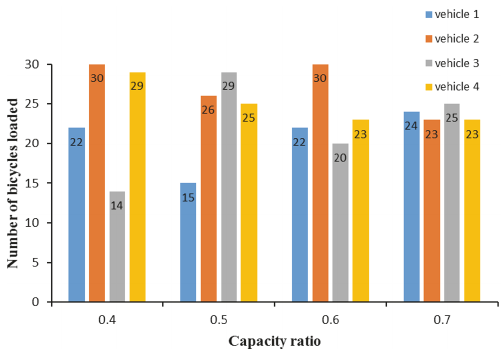
Figure 7: The number of bicycles loaded for the coefficient of load capacity